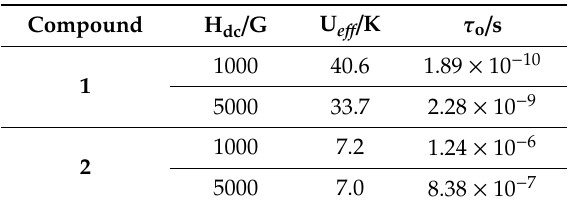
Figure 5. Frequency dependence of the out-of-phase ac susceptibility signals under dc fields of 1000 ( a ) and 5000 G ( b ) for compound 2 . The respective inset shows the ln(τ) versus 1/T plot for 2 with the fit performed through the Arrhenius law (solid line) corresponding to the Orbach mechanism. Table 2. U e ff and τ o values obtained through the dc applied magnetic fields of 1000 and 5000 G and the Arrhenius law for 1 and 2